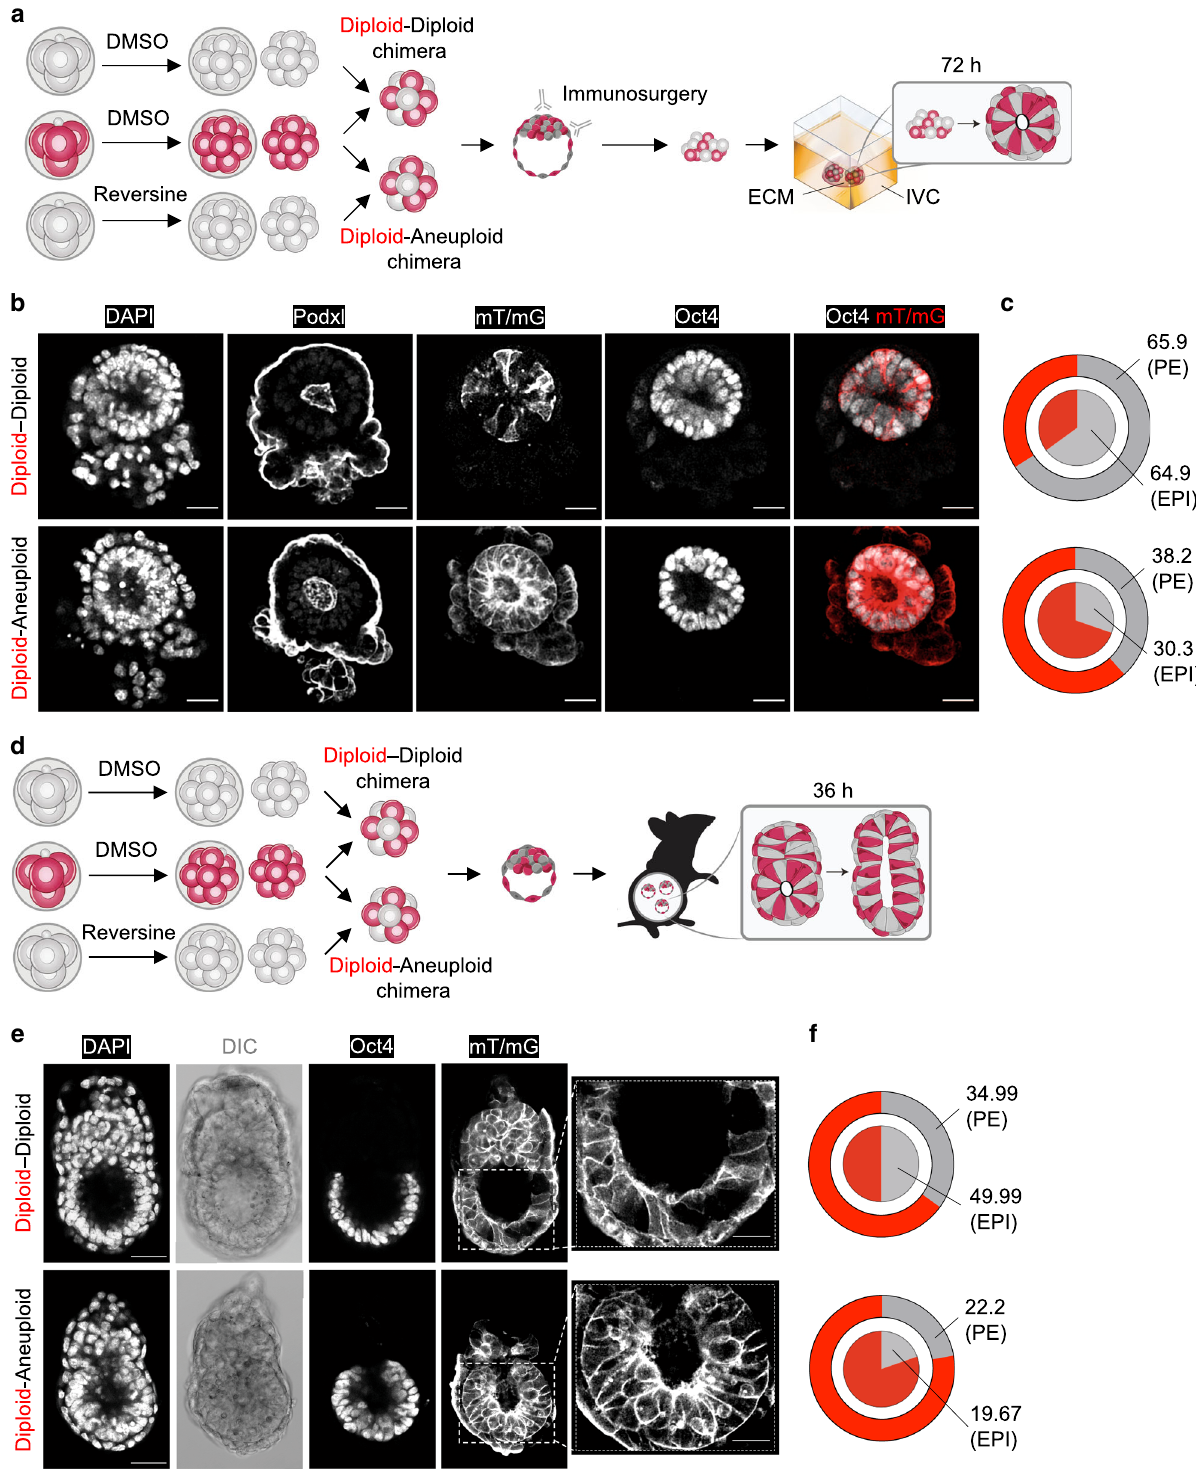
non- fl uorescent aneuploid cells in diploid – aneuploid primitive endoderm was 22.2% while the frequency of non- fl uorescent diploid cells in diploid – diploid primitive endoderm was 34.99% (Fig. 1f). However, this decrease in the relative proportion of non- fl uorescent cells in the diploid (red) – aneuploid (non- fl uorescent) chimeras than in the diploid (red) – diploid (non- fl uorescent) chimeras was not signi fi cant in the primitive endoderm (Supple- mentary Fig.